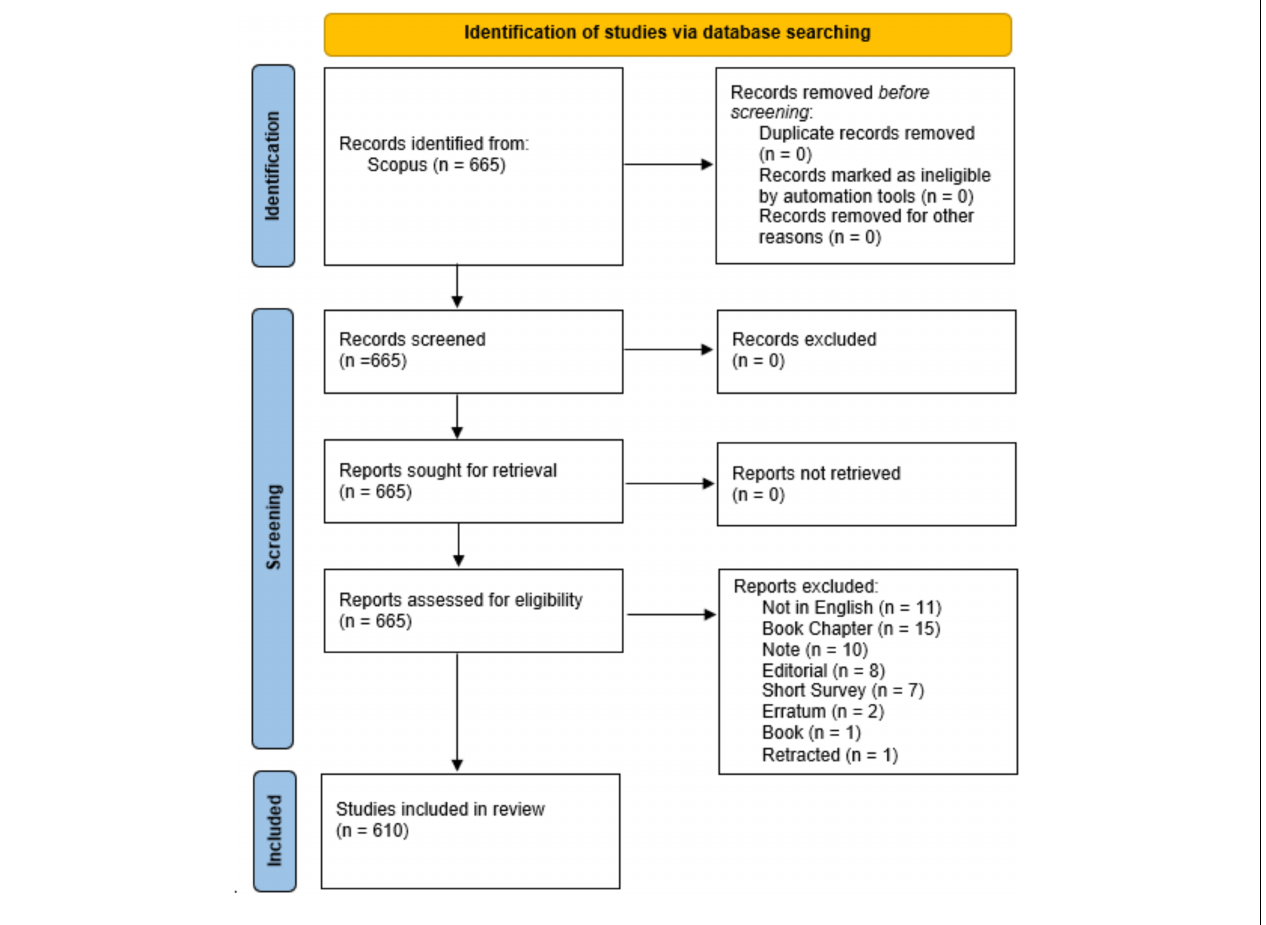
FIGURE 1 | The PRISMA 2020 statement. TABLE 1 | Summary of descriptive information on the collection found from 2012 to